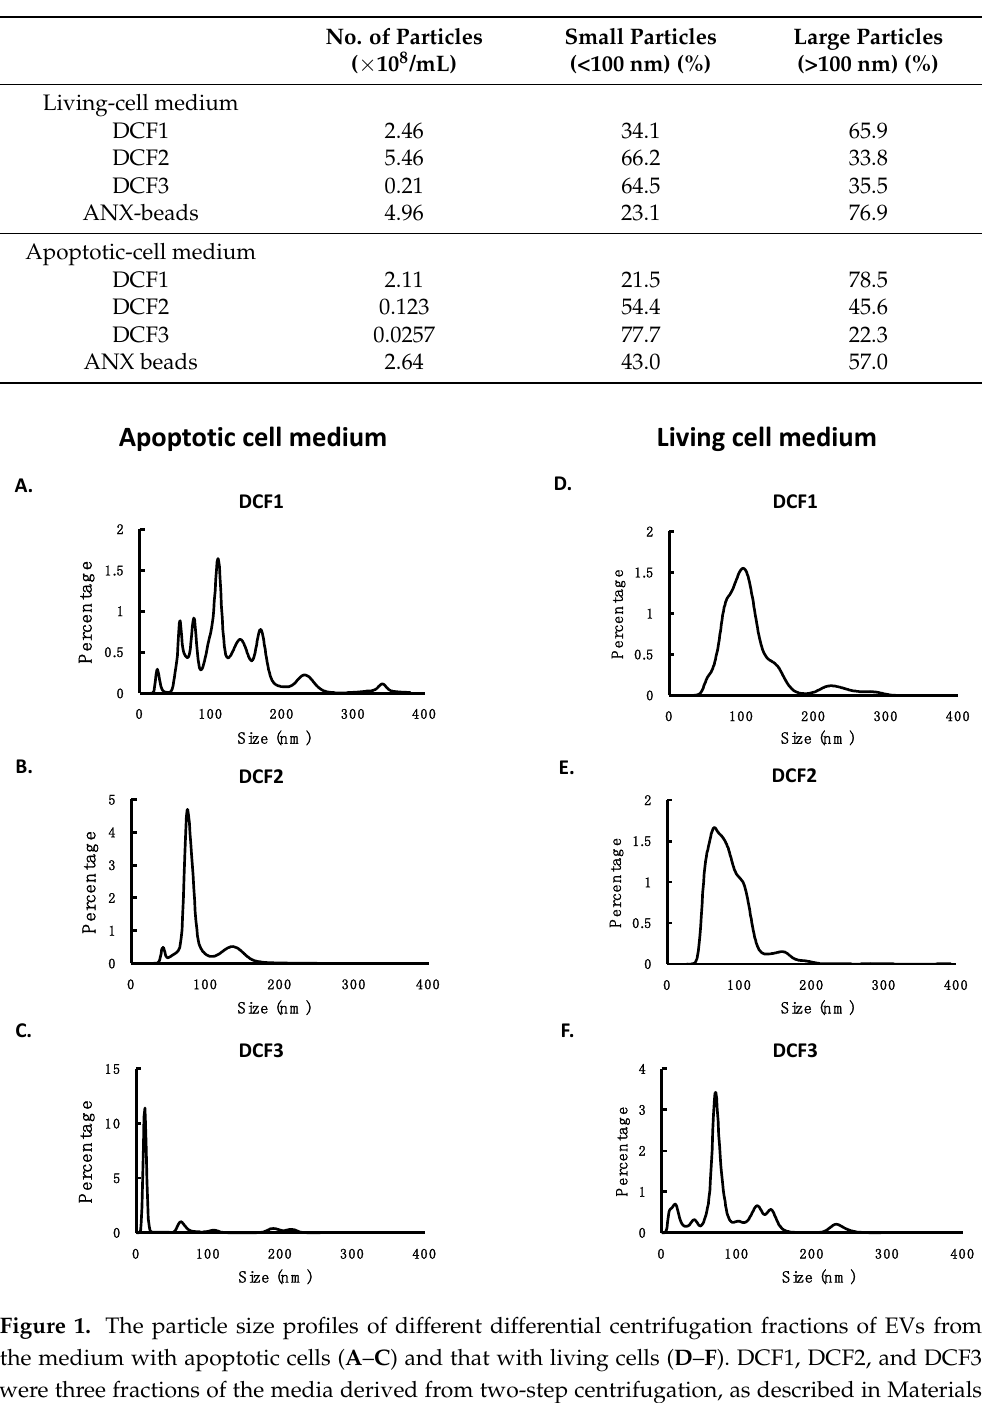
Table 1. The concentration and size distribution of particles fractionated by differential centrifugation or captured by ANX beads.